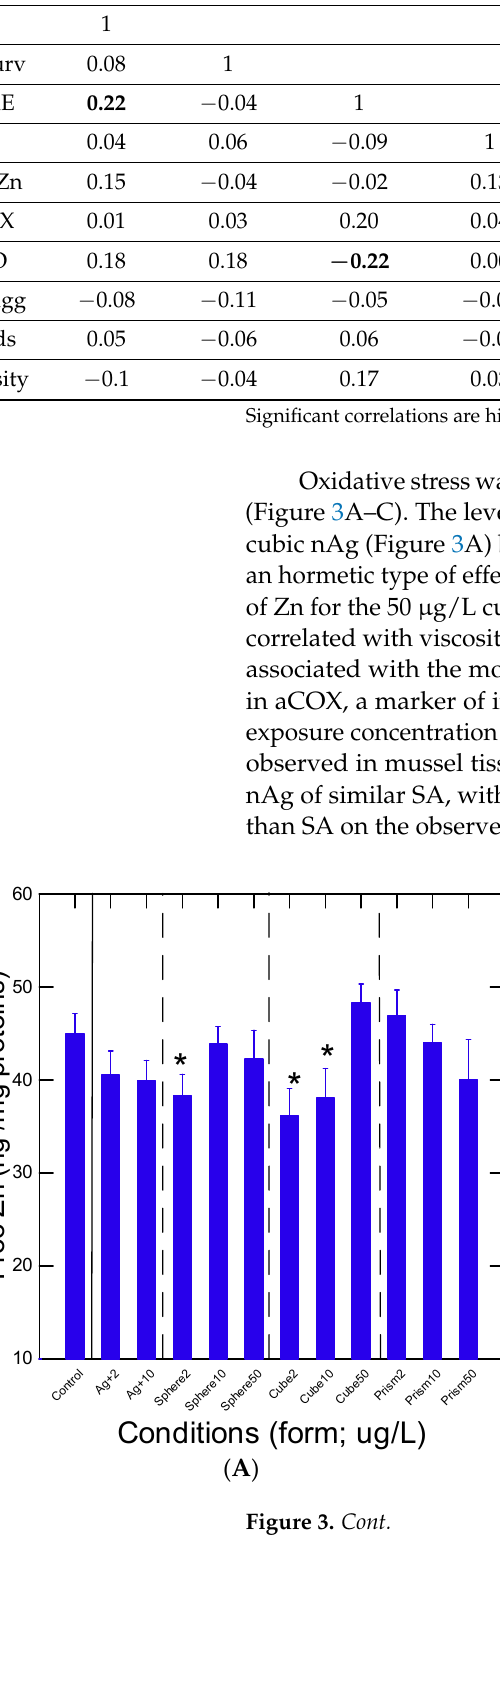
Figure 2. Changes in cytoplasm properties in mussels exposed to nAg forms. Mussel whole tissue homogenate fractions were isolated and analyzed for viscosity ( A ), protein aggregation changes ( B ) and neutral lipids ( C ). The data represent the mean with the standard error. The star symbol * Table 2. Correlation analysis of biomarker data. indicates significant differences from controls. Table 2. Correlation analysis of biomarker data.